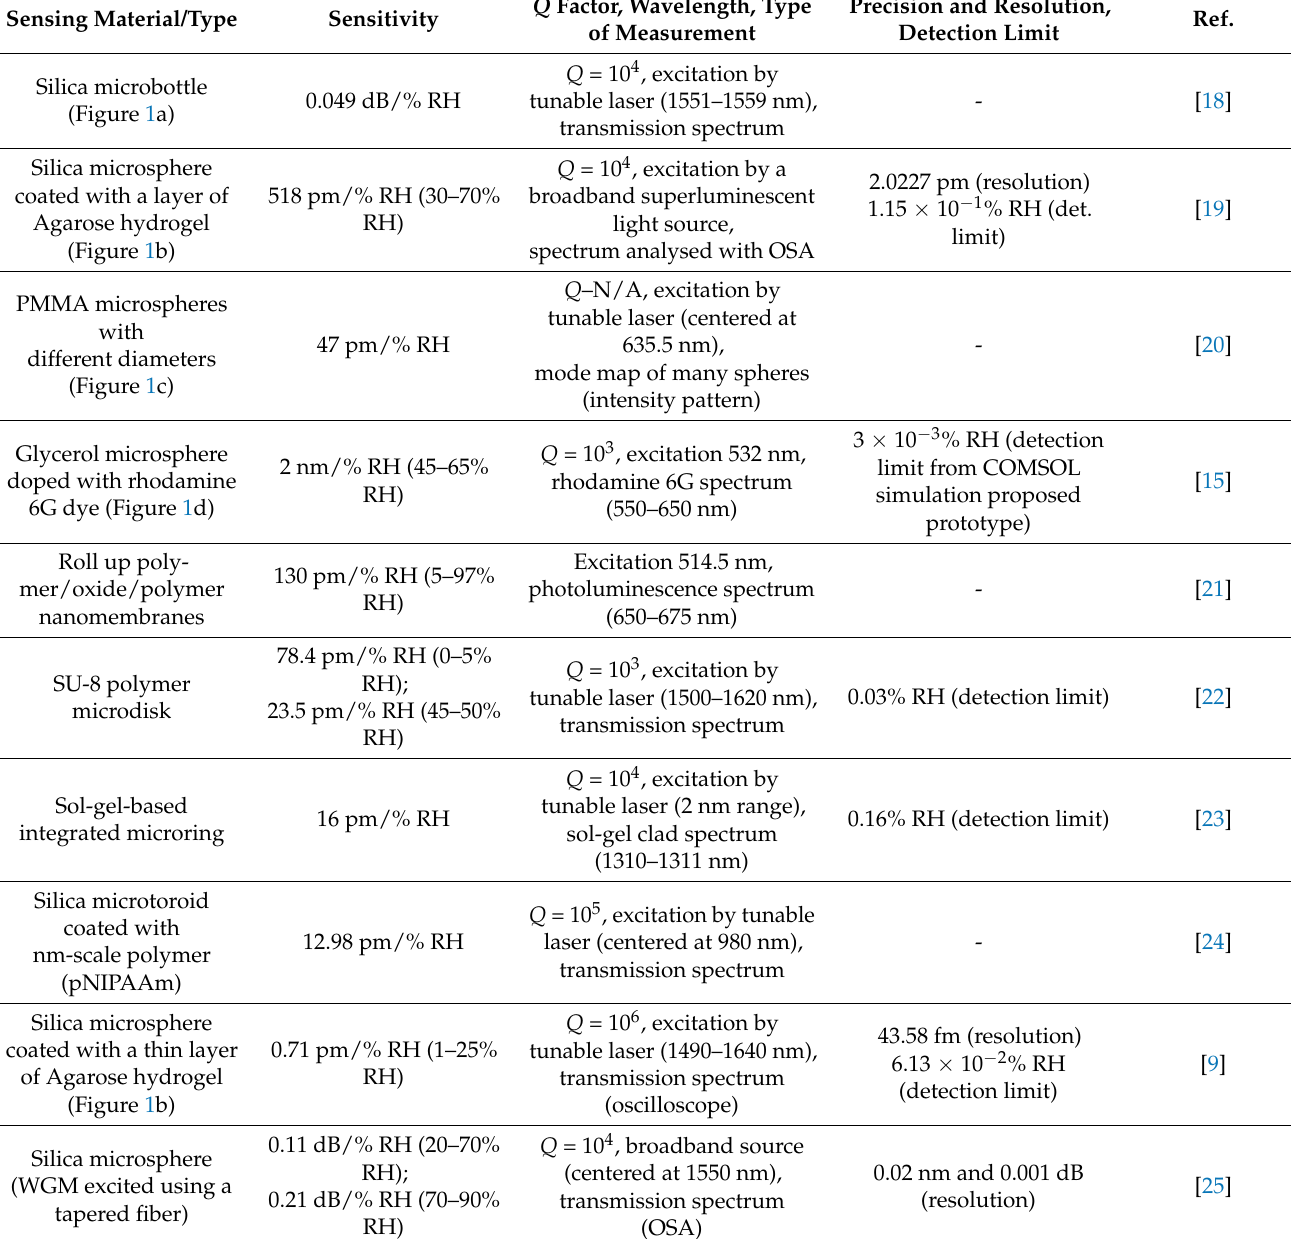
Table 1. Overview of previous research on WGM humidity